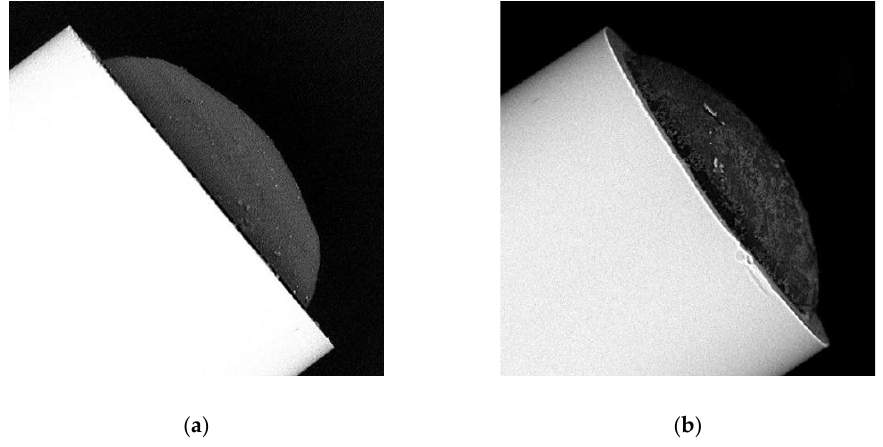
Figure 3. SEM image of polymer microtip on MMF 105, P = 30 µW, T = 60 s, produced using ( a ) UV LED (UV microtip); ( b ) VIS LED (VIS